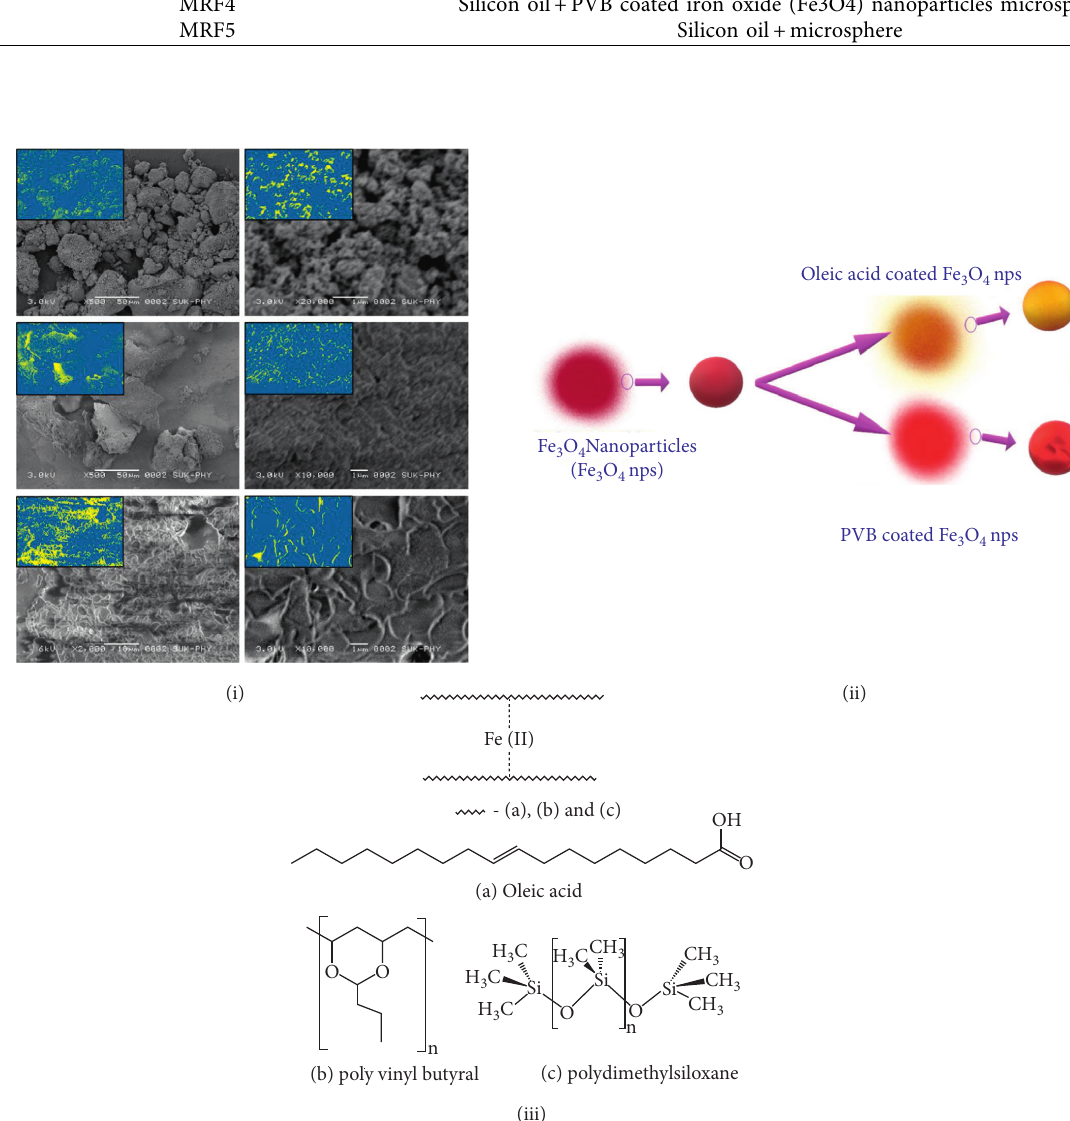
Figure 2: (a): SEM images of (A) iron oxide (Fe 3 O 4 ) particles slightly agglomerated, (B) oleic acid-coated Fe 3 O 4, and (C) PVB-coated Fe 3 O 4 particles separated with gaining smoother surface. (b) Schematic representation of the coating with a zoomed view of a single particle. Oleic acid coating attains Fe nanoparticles to yellow-brownish coloration, whereas PVB gives glassy surface to the particles; it can be seen clearly in the SEM (C) images also. (c) Schematic representation of molecular interaction of Fe nanoparticles with a polymeric moiety.